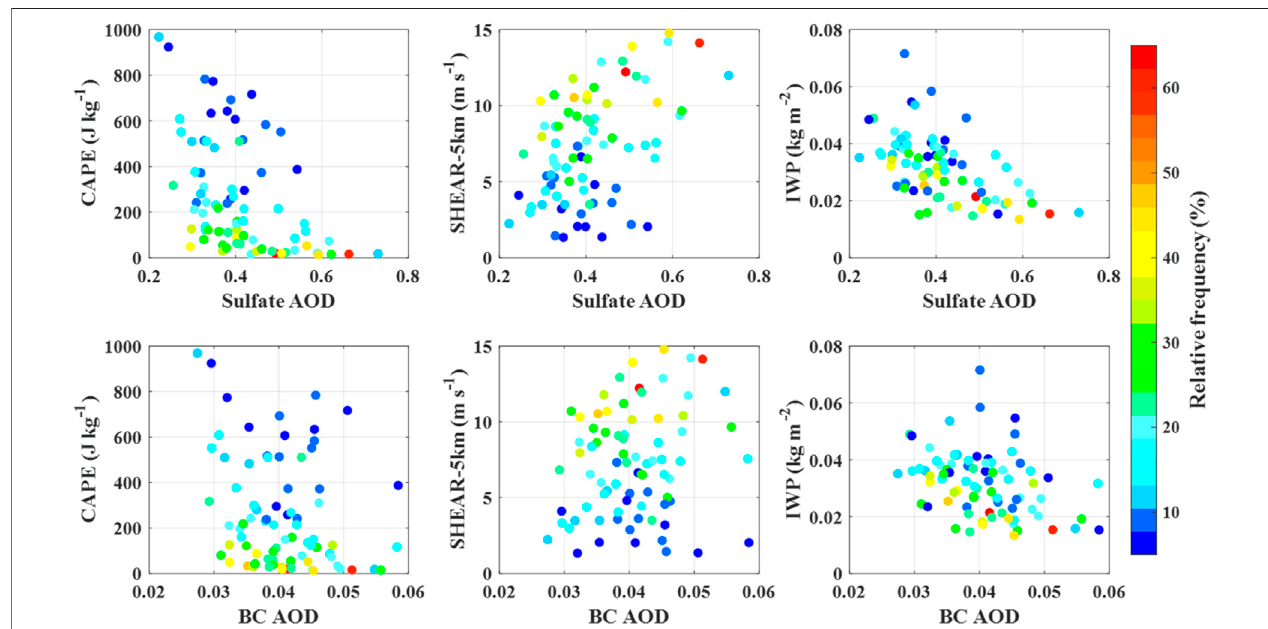
FIGURE 6 | Function of positive CG lightning relative frequency with sulfate AOD, BC AOD, CAPE, SHEAR-5 km, and IWP in the basin region.